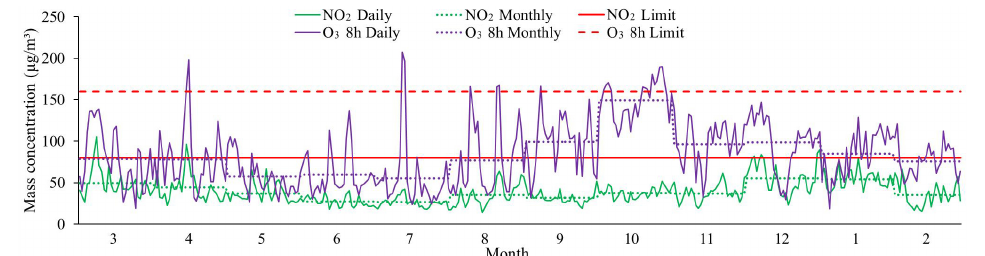
Figure 2. Variation of mass concentration of PM 10 and PM 2.5 in Shenzhen from March 2013 to February 2014.